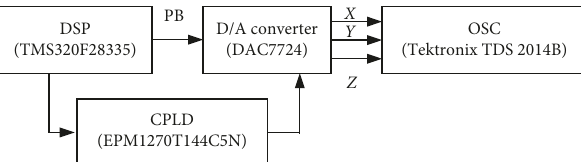
Figure 9: Block diagram for DSP implementation of chaotic attractors and its